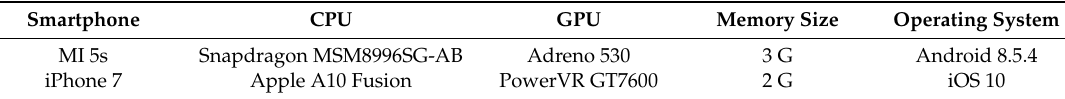
Table 3. Specifications of the two smartphones used for